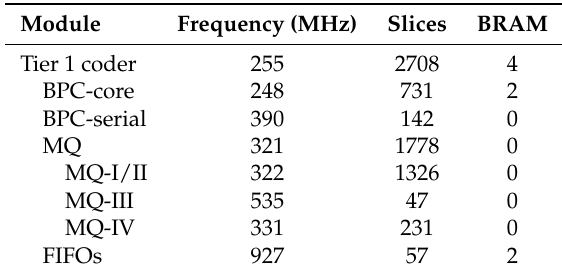
Table 1. Frequency and occupancy for the different modules that make the full tier 1 coder. Results are for the Virtex-7 XC7VX690T board with a depth of 32 set for all queues. Module Frequency (MHz)